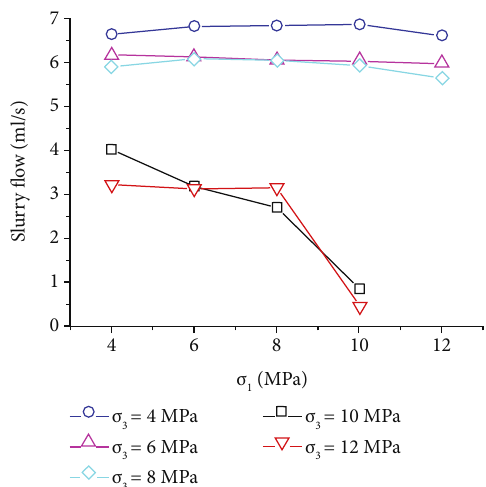
Figure 15: Flow rate under three-dimensional stress.